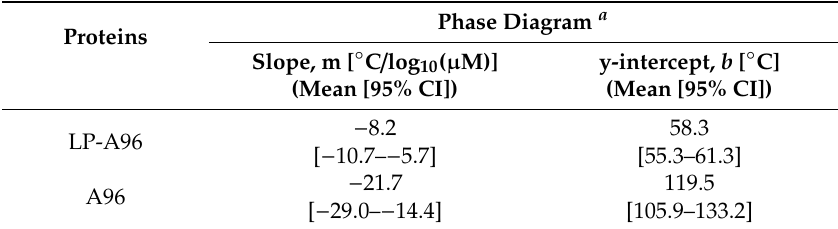
a Fit according to Equation